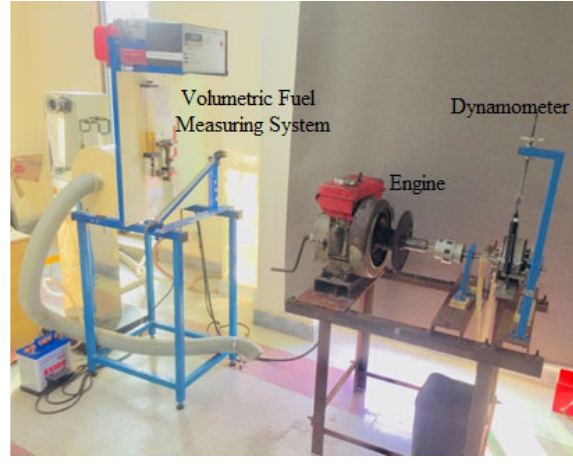
Figure 7. The setup of engine for investigations.